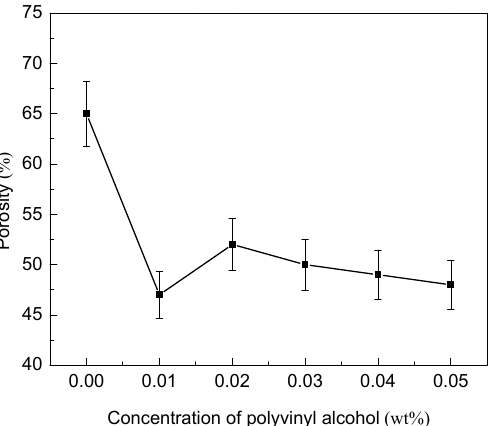
Figure 4. Effect of added PVA contents on the porosity of MWCNTs/PVDF conductive membranes.